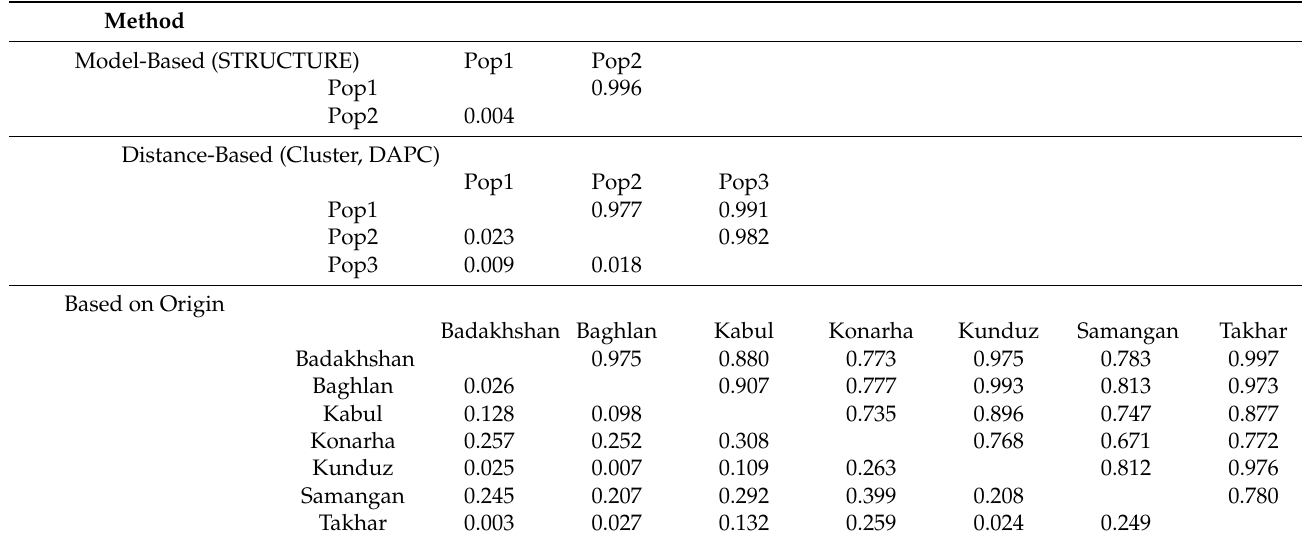
Table 4. Genetic distance among the populations by different